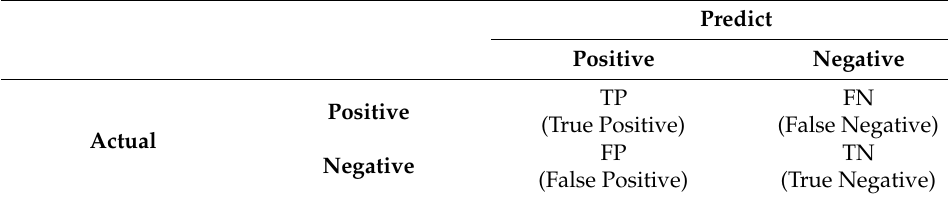
Table 6. Confusion matrix for positive and negative